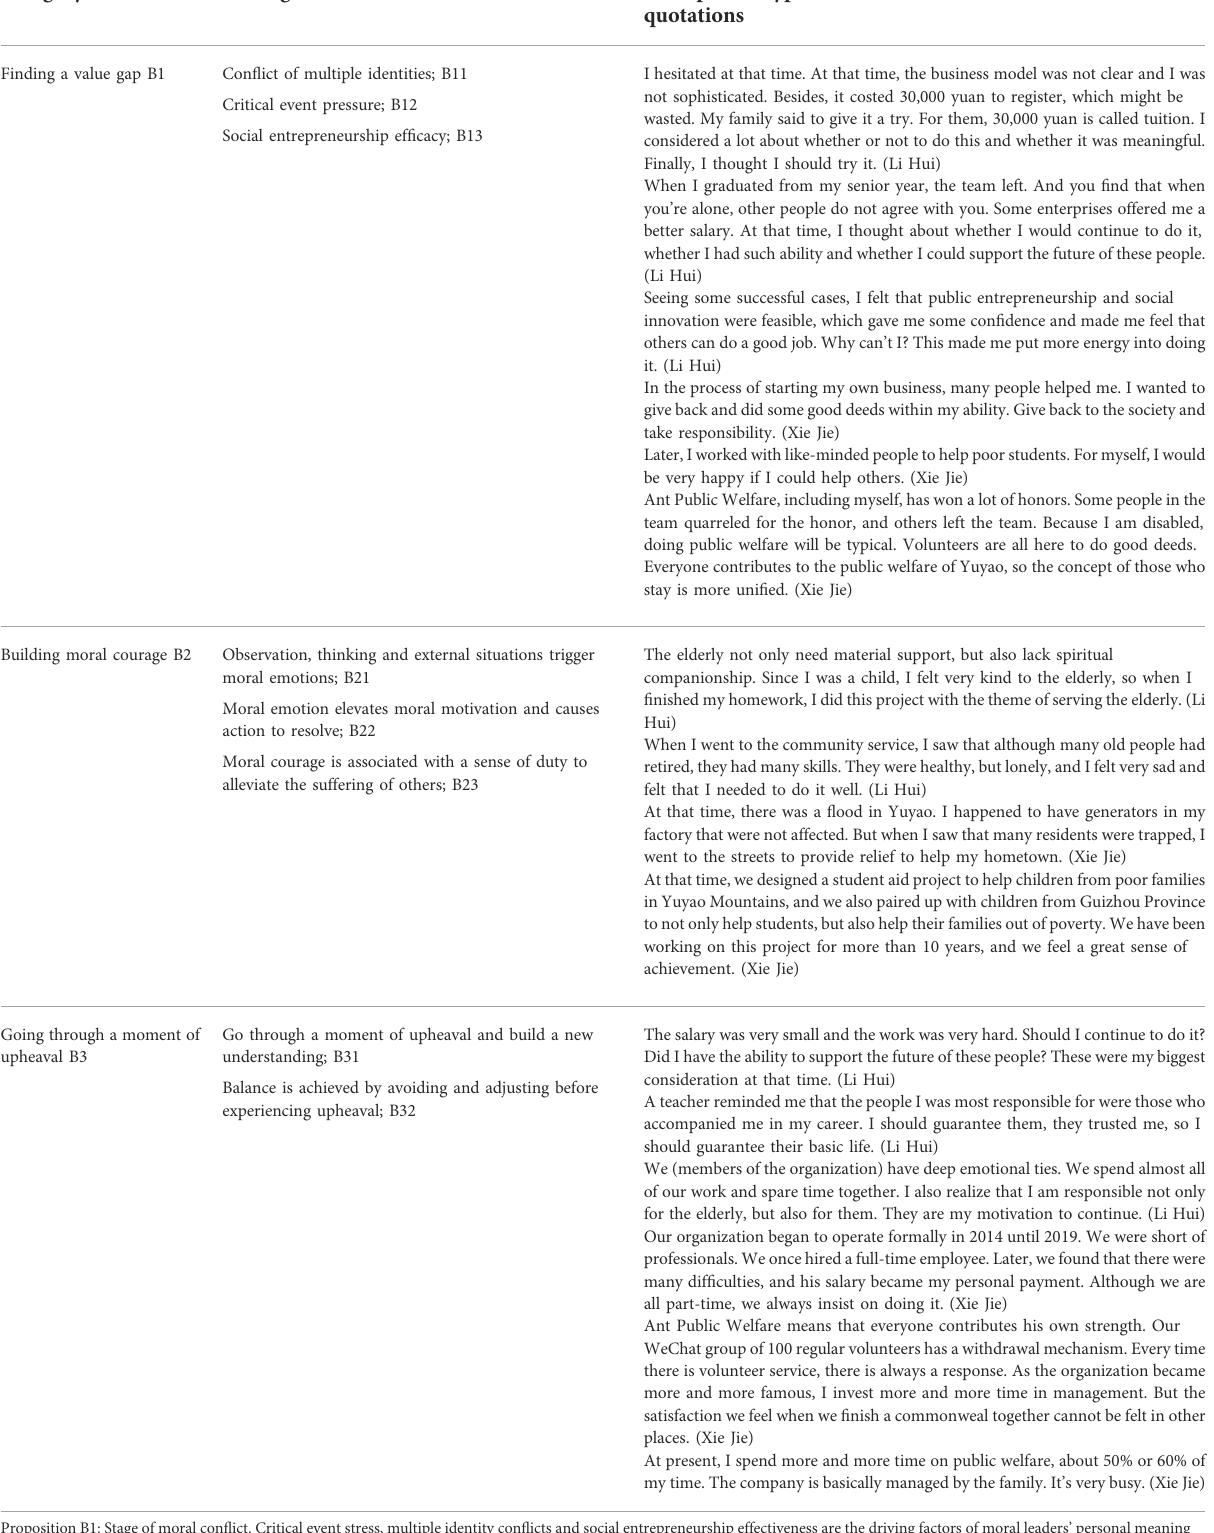
TABLE 4 Examples of typical statements in the stage of moral con fl ict and related